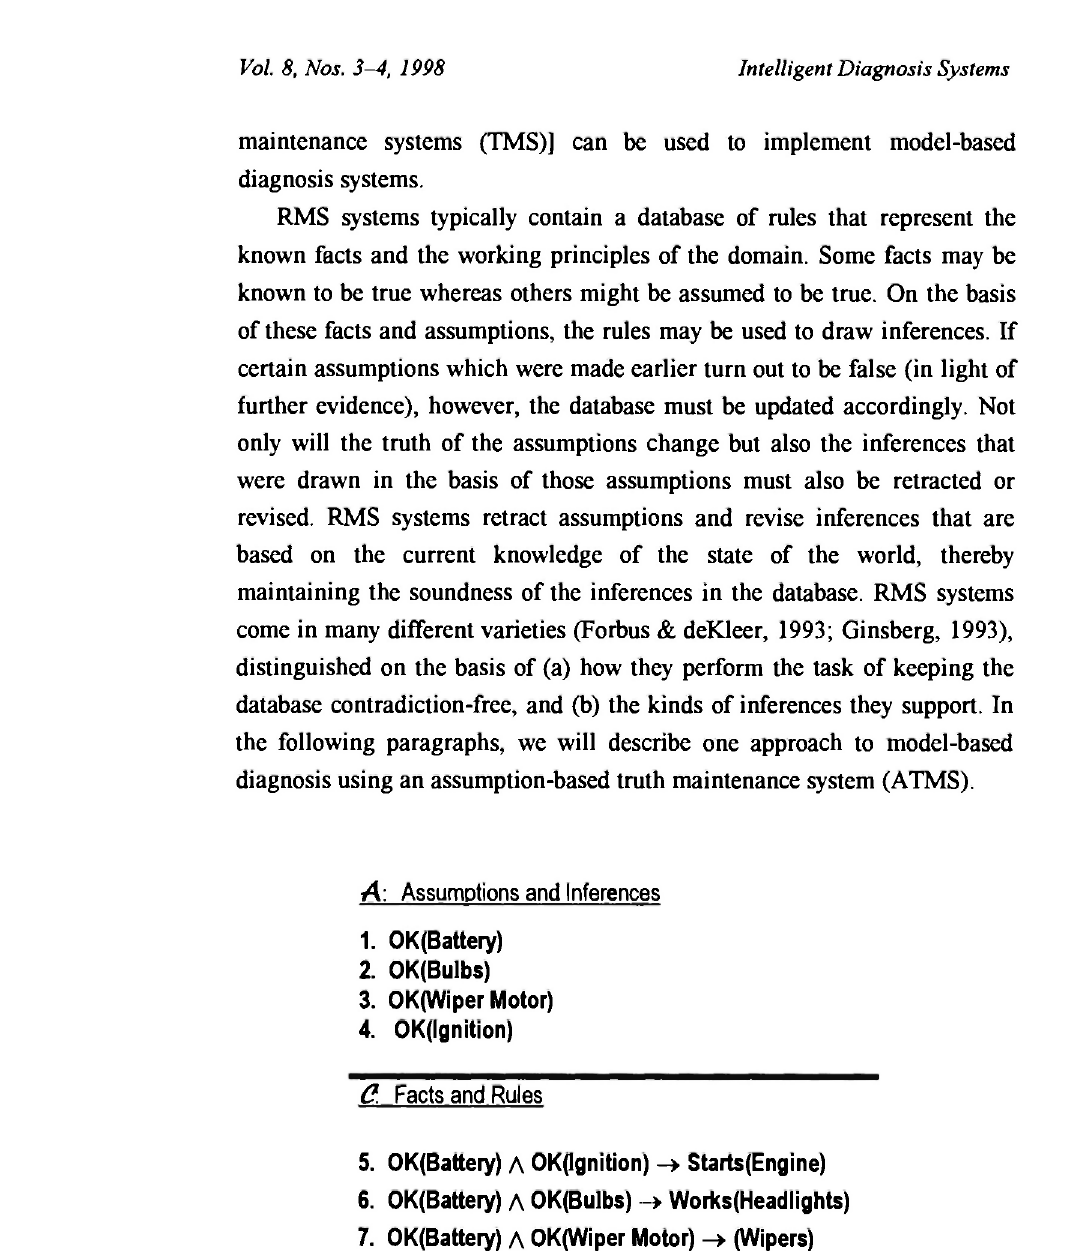
Fig. 3: A database of an ATMS system for the automobile diagnosis example. C contains sentences that are known to be true and